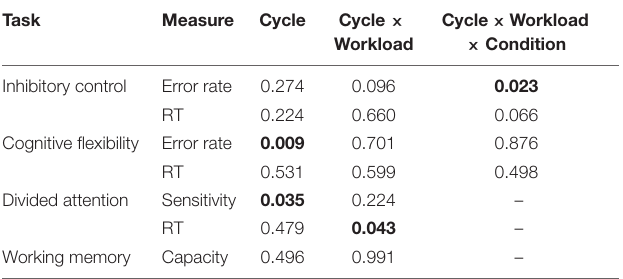
TABLE 2 | Summary of main findings involving menstrual